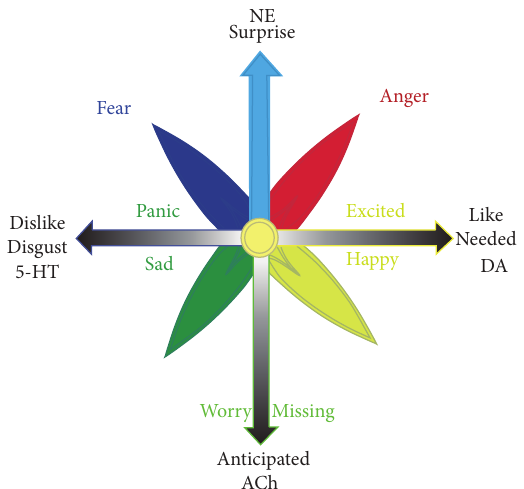
Figure 5: Emotions are due to the hedonic value of the things (physiological needs) and also the way things occur (safety needs) . The way everything occurs not only induces stressful emotions but also affects the tension of hedonic emotions. The neurotransmitters for these emotions are dopamine (a pleasant marker) and serotonin (unpleasant marker). NE is surprise marker, while Ach is a marker for anticipation. NE is well known for fight (anger) or flight (fear)